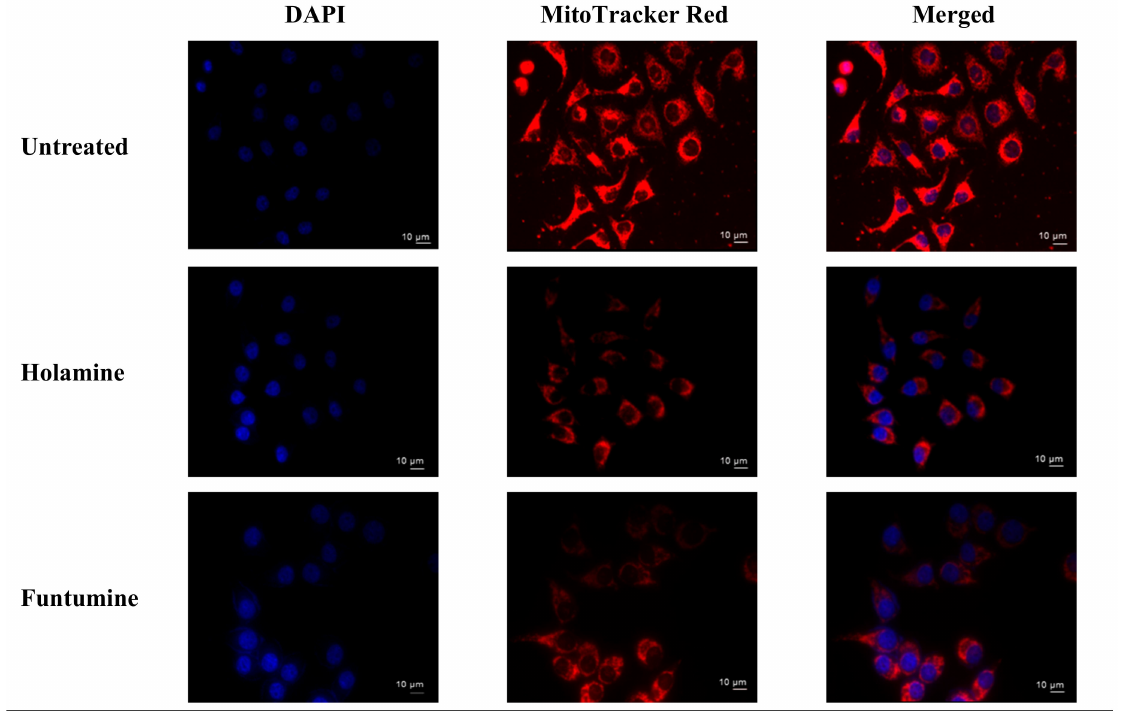
Figure 4. E ff ects of holamine and funtumine on HeLa cell mitochondria. Cells were stained both with Mitotracker red (red) and DAPI (4 (cid:48) ,6-diamidino-2-phenylindole) (blue) after 12 h treatment and viewed by fluorescence microscopy (magnification × 400). Scale bars are indicated on the